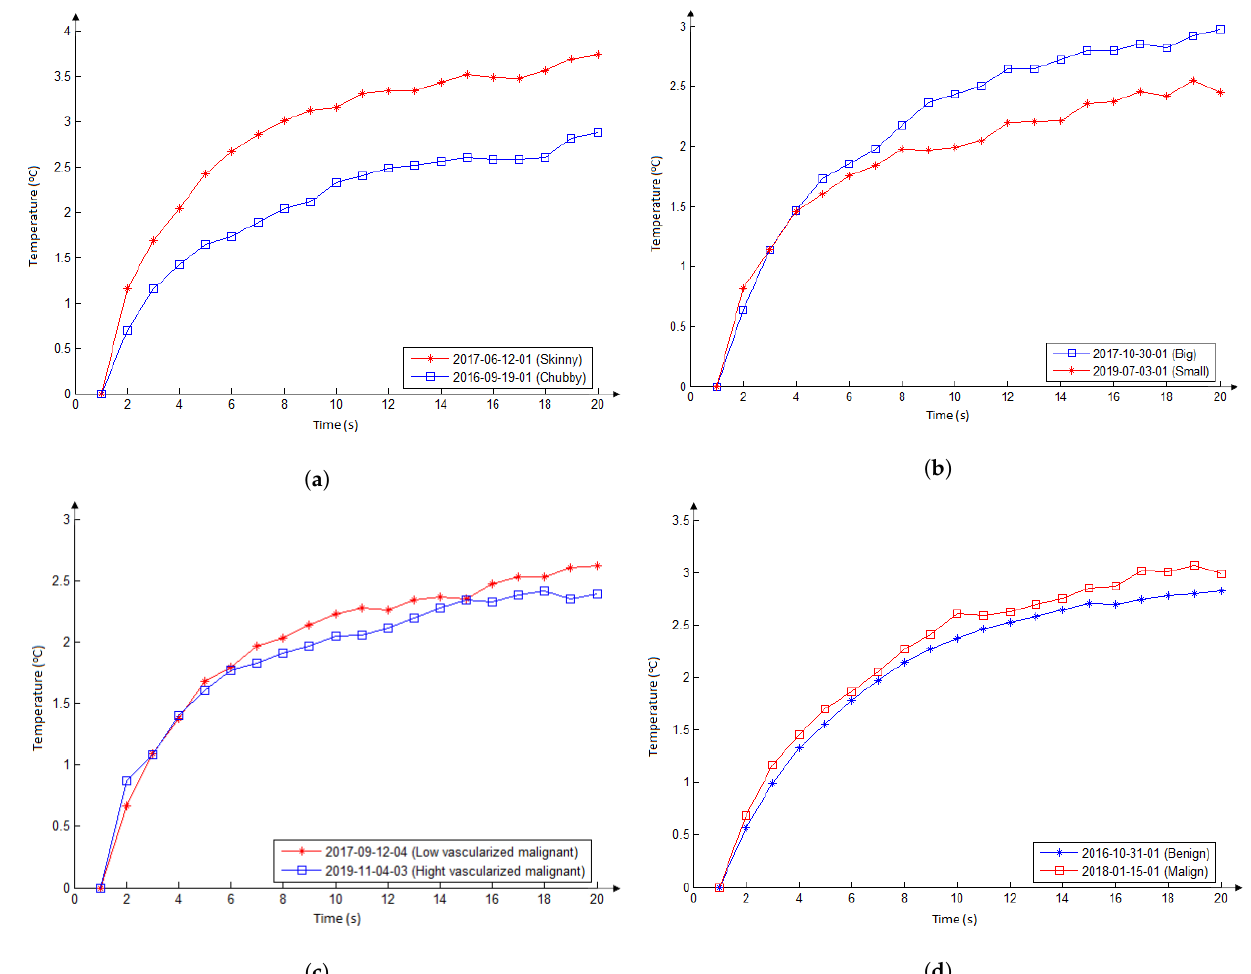
Figure 13. Temperature series in front of eight nodules of patients of Figure 6 obtained by the infrared imaging comparing: two benign nodules from two patients with different BMI indexes ( a ), two malignant nodules with different sizes ( b ), two malignant nodules with different pattern of vascularization ( c ), and a benign with a malignant nodule ( d ) as commented in Section